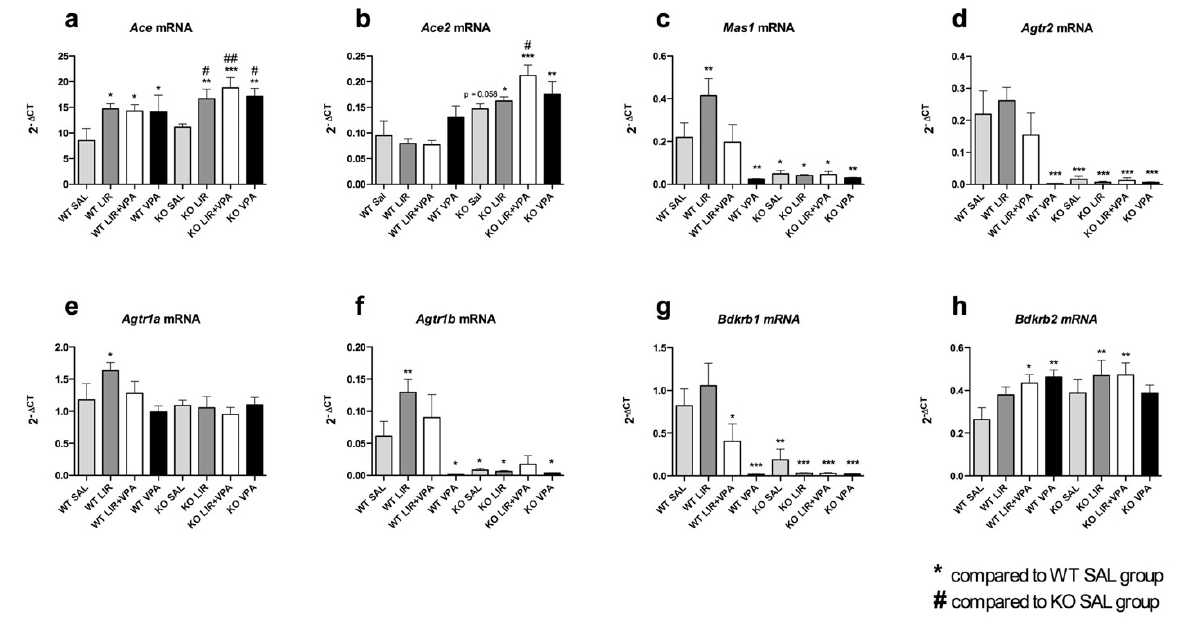
Figure 1. In the lungs, in Wfs1 -deficiency there is tremendous downregulation of Mas1 , Agtr2 , Agtr1b and Bdkrb1 . Gene expression analyses were performed on the lungs of 3.5–4-month-old animals after 8 days of treatment with liraglutide (LIR), valproate (VPA), liraglutide + valproate (LIR + VPA), or saline (SAL). The relative expression level was detected for ( a ) Ace mRNA, ( b ) Ace2 mRNA, ( c ) Mas1 mRNA, ( d ) Agtr2 mRNA, ( e ) Agtr1a mRNA, ( f ) Agtr1b mRNA, ( g ) Bdrkb1 mRNA and ( h ) Bdrkb2 mRNA. Gene expression level is presented as 2 −Δ CT relative to the housekeeper Tbp . Data were compared using factorial ANOVA, followed by Fisher’s LSD post-hoc tests; * p < 0.05; ** p < 0.01; *** p < 0.001 compared to WT vehicle (SAL) group and # p < 0.05; ## p < 0.01 compared to KO vehicle (SAL) group. The data are presented as the mean ± SEM, n = 7–8 per group.